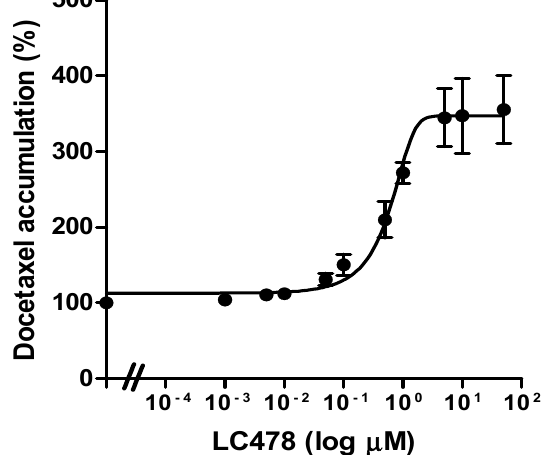
Figure 3. Effect of LC478 on P-gp activity. The EC 50 curves of LC478 on docetaxel accumulation in Caco-2 cells. The vertical bar represents SEM and the number of each group is three.